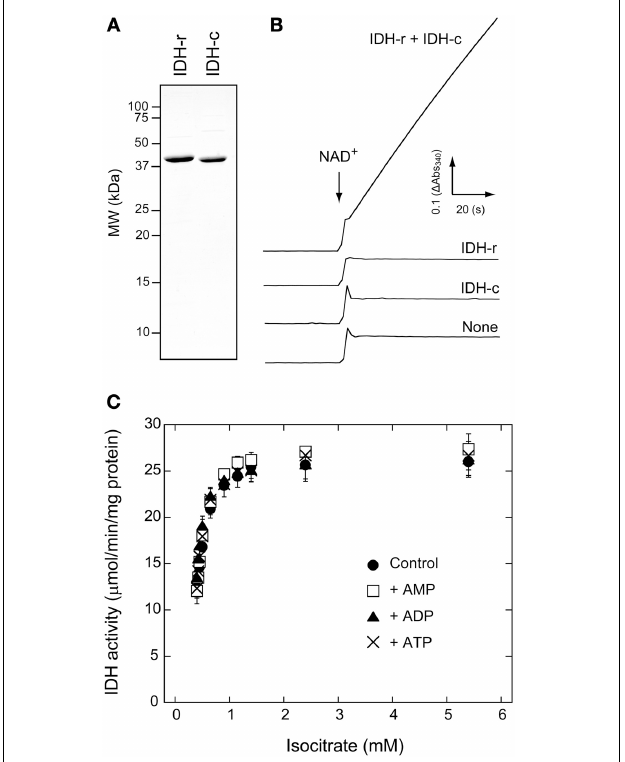
FIGURE 1 | Activity measurements of Arabidopsis IDH recombinant protein. (A) SDS-PAGE profiles of purified recombinant IDH-r and IDH-c. (B) Monitoring of NAD + -reducing activity of IDH. Time course of absorbance change at 340nm (Abs 340 ) is shown. IDH-r and/or IDH-c